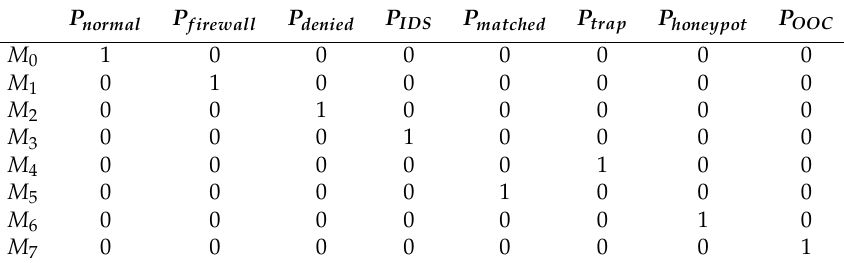
Figure 14. The reachable graph for Scenario II. Table 10. Reachable markings’ set of Scenario